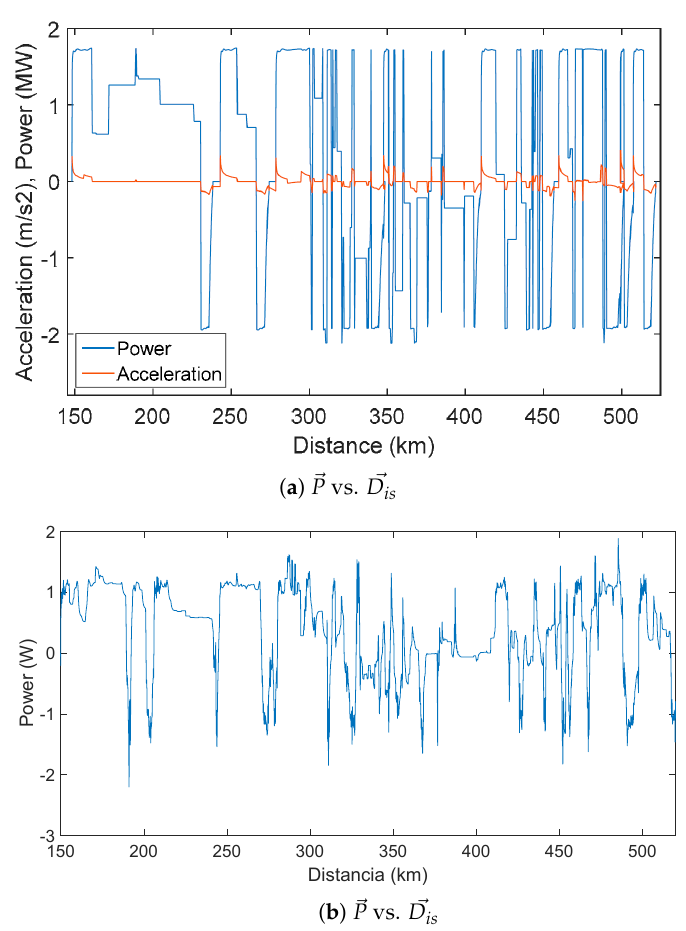
Figure 11. ( a ) Power vs. distance profile reprinted from [21] under CC BY 4.0 license and ( b ) Power vs. distance profile obtained with the proposed